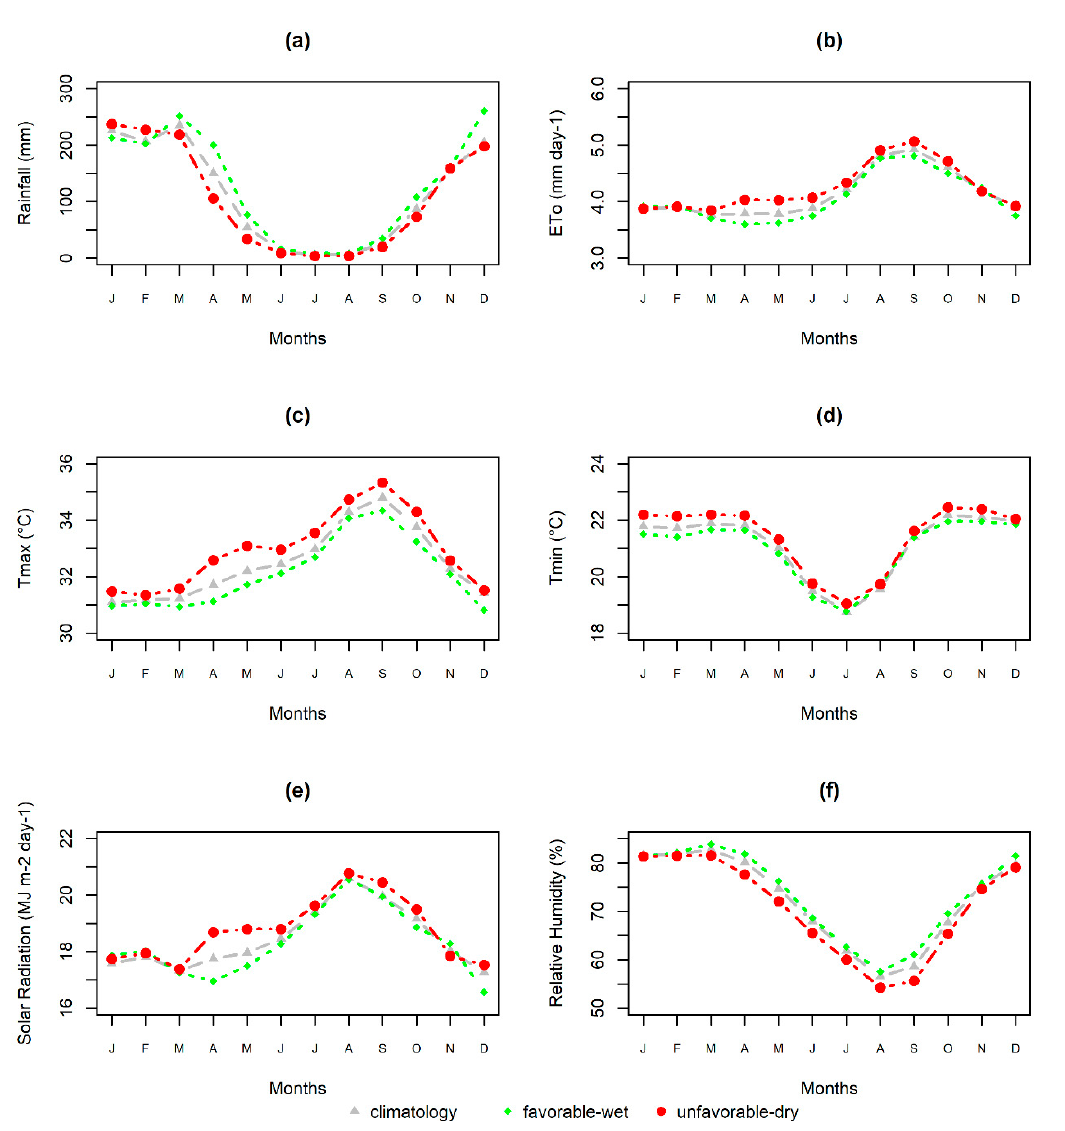
Figure 2. Mean monthly values of the meteorological variables in the period from 1980 to 2013 in the MATOPIBA region regarding the climatology, the favorable scenario (wet), and the unfavorable scenario (dry). ( a ) Rainfall, ( b ) ETo: Reference Evapotranspiration, ( c ) Tmax: Maximum Temperature, ( d ) Tmin: Minimum Temperature, ( e ) Solar Radiation and ( f ) Relative Humidity.